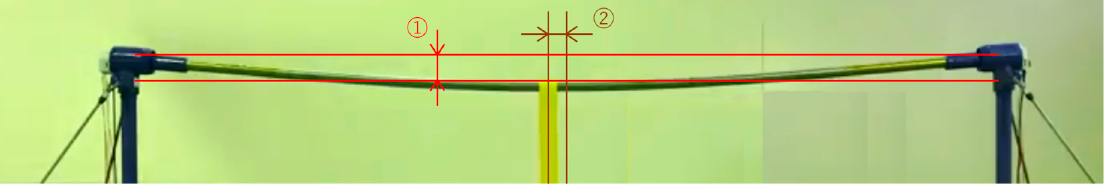
Figure 3. Displacement of the bar. ① Displacement of the bar: 68.75 mm. ② Distance from the center position of the bar to the maximum deflection position: 53.06